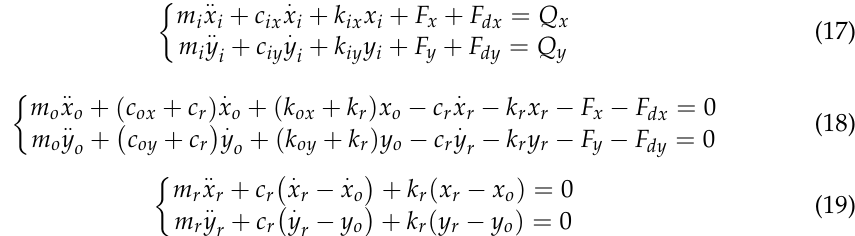
Table 1. Geometrical specifications of 6205-2RS JEM SKF deep-groove bearing [60,61]. Parameter